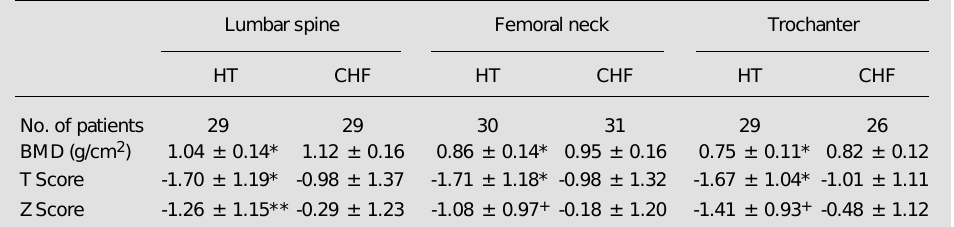
Table 3 - Bone mineral density (BMD) of heart transplant (HT) and chronic heart failure (CHF) patients. Data are reported as means ± SD. BMD, Bone mineral density. *P<0.05 versus CHF patients. **P<0.007 versus CHF patients. + P<0.004 versus CHF patients (Mann-Whitney test). Lumbar spine Femoral neck